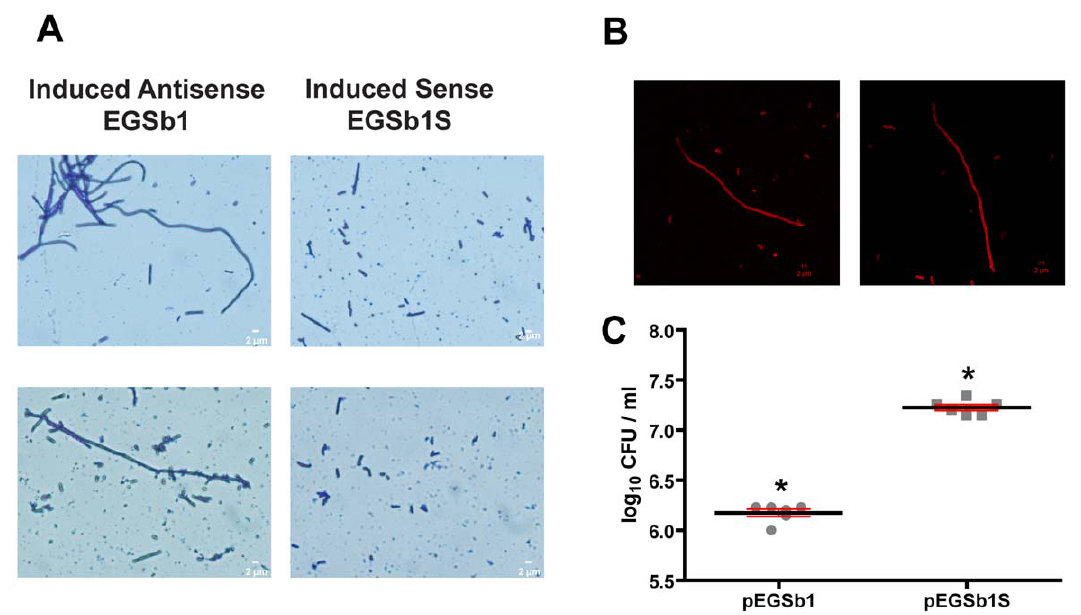
Figure 4. Effect of EGSb1 on cell division. A. The inducer IPTG (1 mM) was added to cultures of E. coli BL21(DE3)(pLysS) harboring the recombinant plasmids pEGSb1 or pEGSb1S when their OD 600 reached 0.2. The cultures were then incubated for 60 more minutes and cells were examined by microscopy. B. Cells were stained with FM5-95 as described in Materials and Methods and examined by laser scanning confocal microscopy. C. Effect of the expression of EGSb1 or EGSb1S on cell survival. Results are expressed as log 10 of mean CFU/ml 6 SD. Similar results were observed in 3 independent assays. *: p , 0.01.